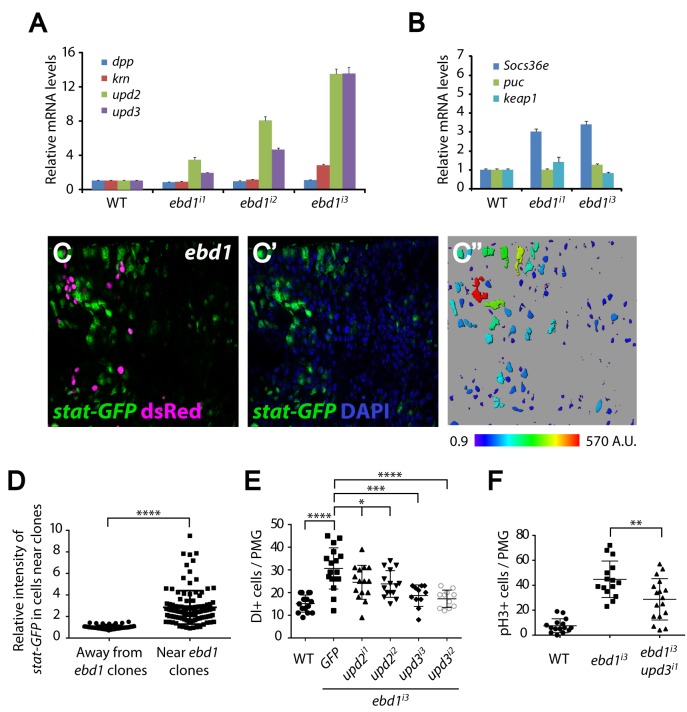
Loss of ebd1 non-autonomously activates the Jak/Stat pathway to regulate ISC proliferation.(A) Expression of the Jak/Stat pathway ligands, upd2 and upd3, increases upon RNAi-mediated knockdown of ebd1 expression in ECs. Expression of two other ligands secreted by ECs, dpp and krn, is not affected by the loss of ebd1. (B) Increased expression of Socs36e, a downstream target of Jak/Stat signaling, is observed upon RNAi-mediated knockdown of ebd1. Conversely, knockdown of ebd1 has no effect on expression of puc or keap1, indicating that the stress pathways are not activated and that Jak/Stat pathway induction is not a secondary defect due to the induction of a stress response. (C-D) Expression of the Jak/Stat pathway reporter, stat-GFP (green, C and C’), is higher near ebd1 mutant clones (dsRed labeled clones in magenta, C) than far from the clones. Nuclei are marked with DAPI (blue). (C”-D) Imaris was used to quantify stat-GFP intensity near and away from ebd1 mutant clones. **** P<0.0001 (Mann-Whitney test). (E) Concomitant knockdown of upd2 or upd3, as well as ebd1, rescues the ebd1 RNAi phenotype, as measured by Dl positive cells. This indicates that ectopic expression of upd in ECs is responsible for overproliferation of ISCs in ebd1 mutants. **** P<0.0001, *** P<0.001, * P<0.05 (t-test). (F) Concomitant RNAi-mediated knockdown of upd3 and ebd1 rescues the ebd1 RNAi-mediated ISC overproliferation phenotype, as measured by pH3 staining. ** P<0.01 (t-test). Scale bars: (C-C”) 50 μm. Genotypes: (A-B) WT:
Myo1A-Gal4 UAS-GFP tub-Gal80ts/+
ebd1i1: Myo1A-Gal4 UAS-GFP tub-Gal80ts/+; UAS-ebd1 RNAi#1/+
ebd1i2: Myo1A-Gal4 UAS-GFP tub-Gal80ts/+; UAS-ebd1 RNAi#2/+
ebd1i3: Myo1A-Gal4 UAS-GFP tub-Gal80ts/+; UAS-ebd1 RNAi#3/+ (C-D) y w hs-flp tub-Gal4 UAS-dsRed/+; 10xstat-GFP/+; FRT2A tub-Gal80/ebd1240
FRT2A (E) WT:
Myo1A-Gal4 UAS-GFP tub-Gal80ts/+
ebd1i3
GFP:
Myo1A-Gal4 UAS-GFP tub-Gal80ts/+; UAS-ebd1 RNAi#3/UAS-GFP-lacZ
ebd1i3
upd2i1: Myo1A-Gal4 UAS-GFP tub-Gal80ts/+; UAS-ebd1 RNAi#3/UAS-upd2 RNAi#1
ebd1i3
upd2i2: Myo1A-Gal4 UAS-GFP tub-Gal80ts/+; UAS-ebd1 RNAi#3/UAS-upd2 RNAi#2
ebd1i3
upd3i1: Myo1A-Gal4 UAS-GFP tub-Gal80ts/UAS-upd3 RNAi#1; UAS-ebd1 RNAi#3/+
ebd1i3
upd3i2: Myo1A-Gal4 UAS-GFP tub-Gal80ts/+; UAS-ebd1 RNAi#3/UAS-upd3 RNAi#2 (F) WT:
Myo1A-Gal4 UAS-GFP tub-Gal80ts/+
ebd1i3: Myo1A-Gal4 UAS-GFP tub-Gal80ts/+; UAS-ebd1 RNAi#3/+
ebd1i3
upd3i1: Myo1A-Gal4 UAS-GFP tub-Gal80ts/UAS-upd3 RNAi#1; UAS-ebd1 RNAi#3/+.